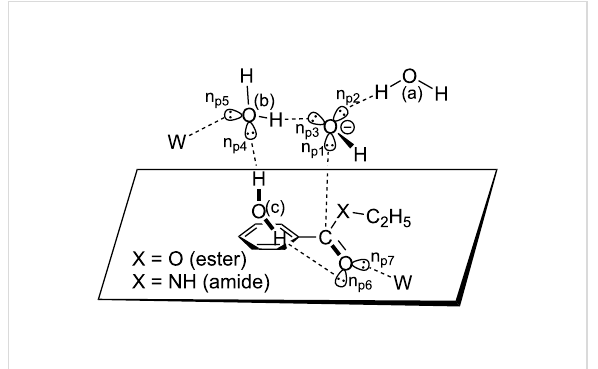
Figure 1: A minimal model of the OH − nucleophilic addition to the sub- strate, Ph–C(=O)–X–Et. Three ((a), (b) and (c), n = 3) water molecules participate in the main hydrogen bonds to stabilize the TS structure. W stands for the water molecule as an outer catalyst. n p denotes the lone-pair orbitals on the oxygen